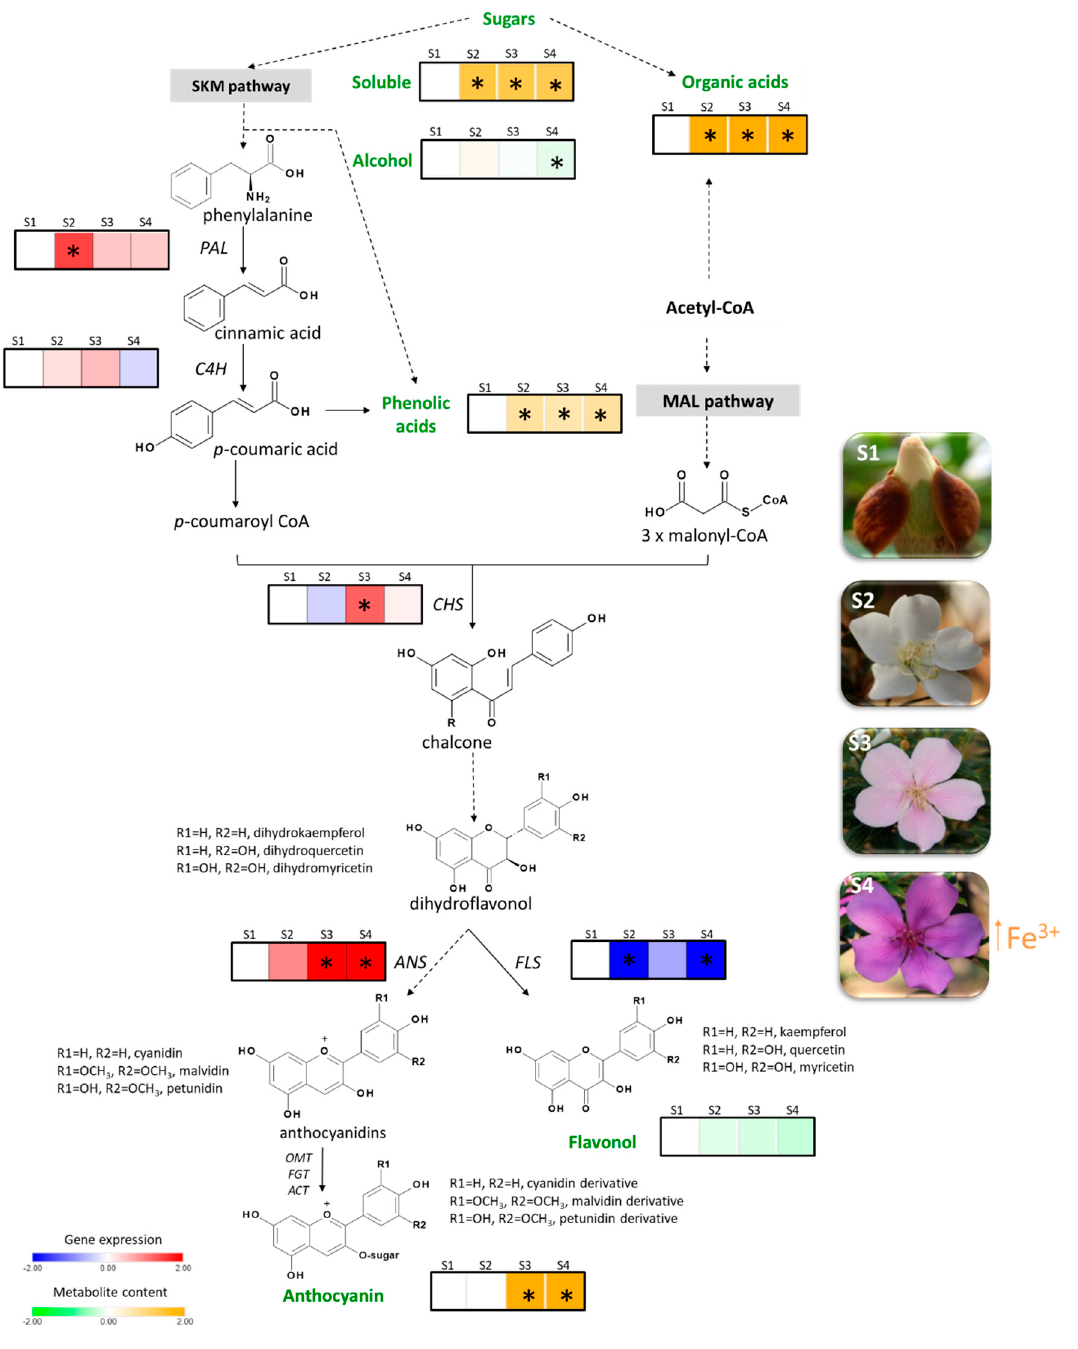
Figure 5. Comprehensive schematic representation of the obtained results. Flavonoid biosynthetic pathway showing heatmaps representing metabolites content (orange to green) and mRNA expression profile (blue to red) relative to the S1 stage. Dotted lines represent more than one enzymatic reaction. Quantified compounds are highlighted in green. Asterisks indicate statistically significant di ff erent values compare to the S1 stage. Abbreviations: PHENYLALANINE AMMONIUM LYASE ( PAL) , CINAMMATE 4-HYDROXYLASE (C4H) , CHALCONE SYNTHASE ( CHS) , FLAVONOL SYNTHASE ( FLS) , ANTHOCYANIDIN SYNTHASE (ANS ), O-METHYLTRANSFERASE ( OMT ), FLAVONOID GLYCOSYL TRANSFERASE ( FGT ) and ANTHOCYANIDIN ACYL TRANSFERASE ( ACT ) genes, S1—buds (day 0), S2—white flowers (day 1), S3—pink (day 2), S4—purple (day